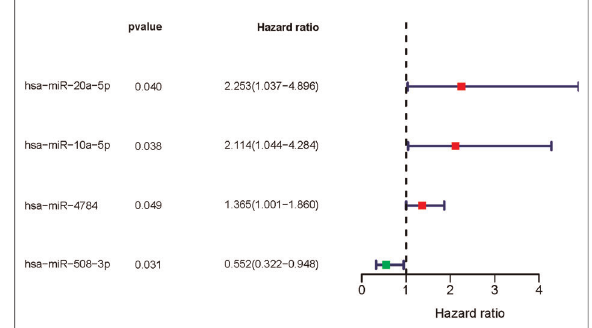
FIGURE 2 Survival-related differentially expressed miRNAs. Forest plot showing the survival-related values (hazard ratios) of DMIRs (hsa-miR-20a- 5p, hsa-miR-10a-5p, hsa-miR-4784, and hsa-miR-508-3p). The red portion represents upregulated sDMIRs, and the green portion represents downregulated